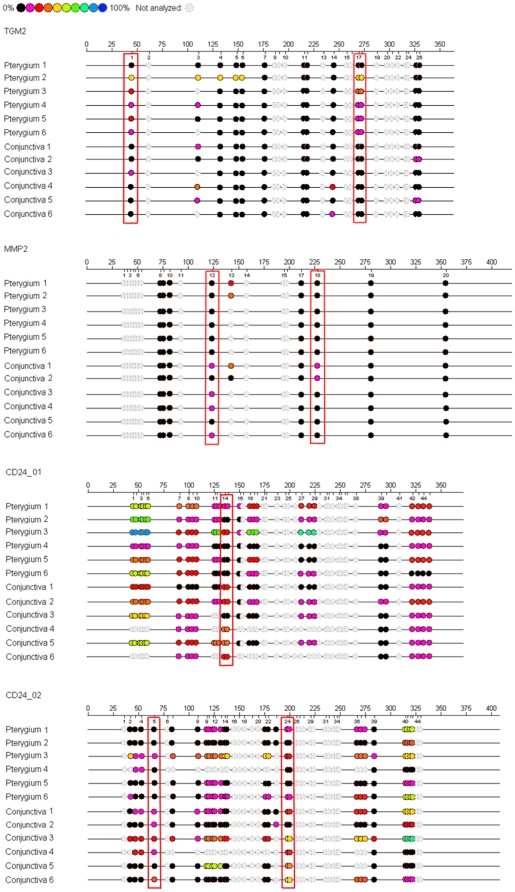
Epigrams showing the nucleotide sequences used in the EpiTYPER Sequenom study.It was obtained from genes known to be important for matrix remodeling and cell adhesion. The brackets in red indicated the differentially methylated CpG sites that were consistent with transcript level changes in pterygium.